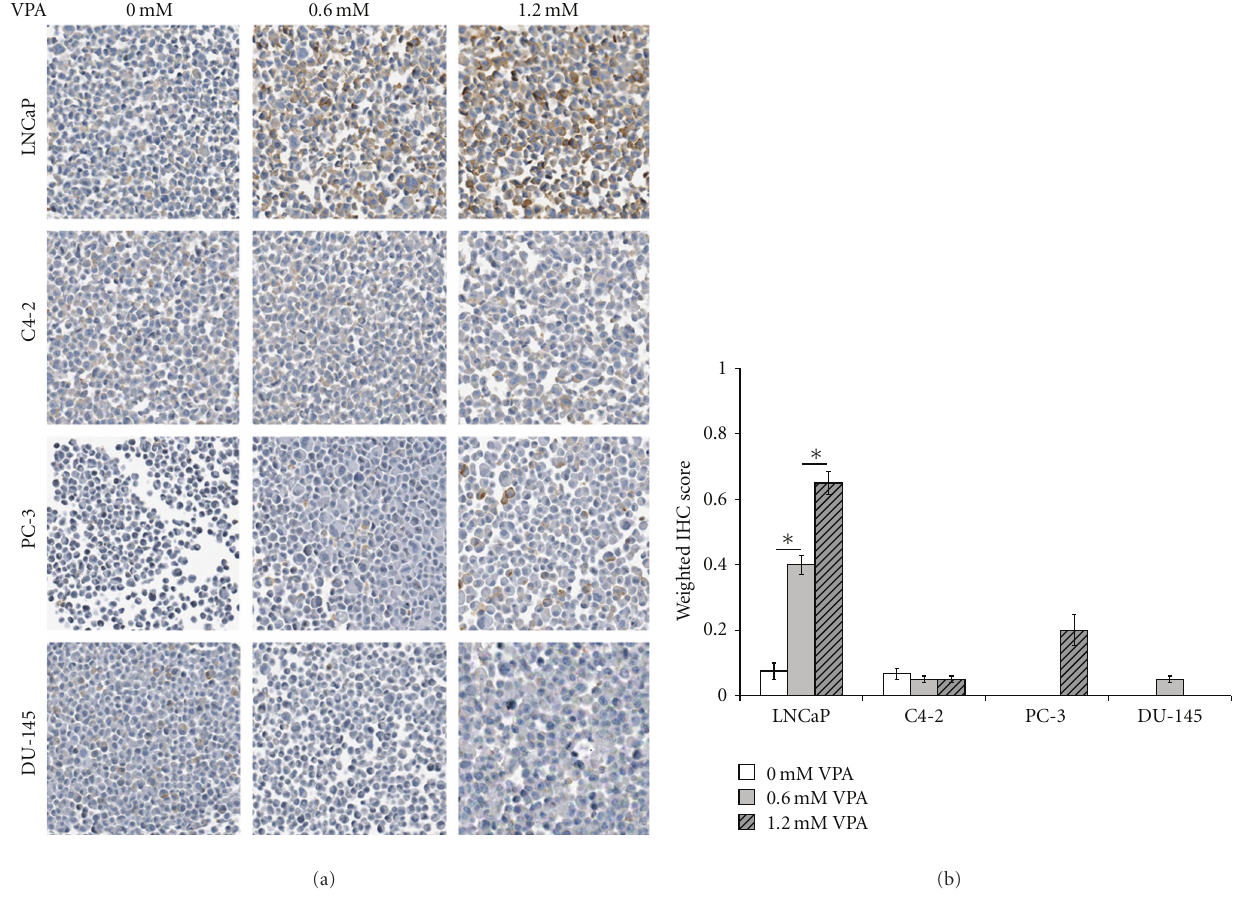
Figure 3: NCAM staining in prostate cancer cells treated with VPA in vitro. (a): Representative images of NCAM staining for cell pellet sections from control and VPA-treated groups: LNCaP, C4-2, PC-3, and DU-145 (scanned at 20X magnification using the APERIO imaging system). (b) Weighted scoring of IHC staining for NCAM ( ∗ indicates P <